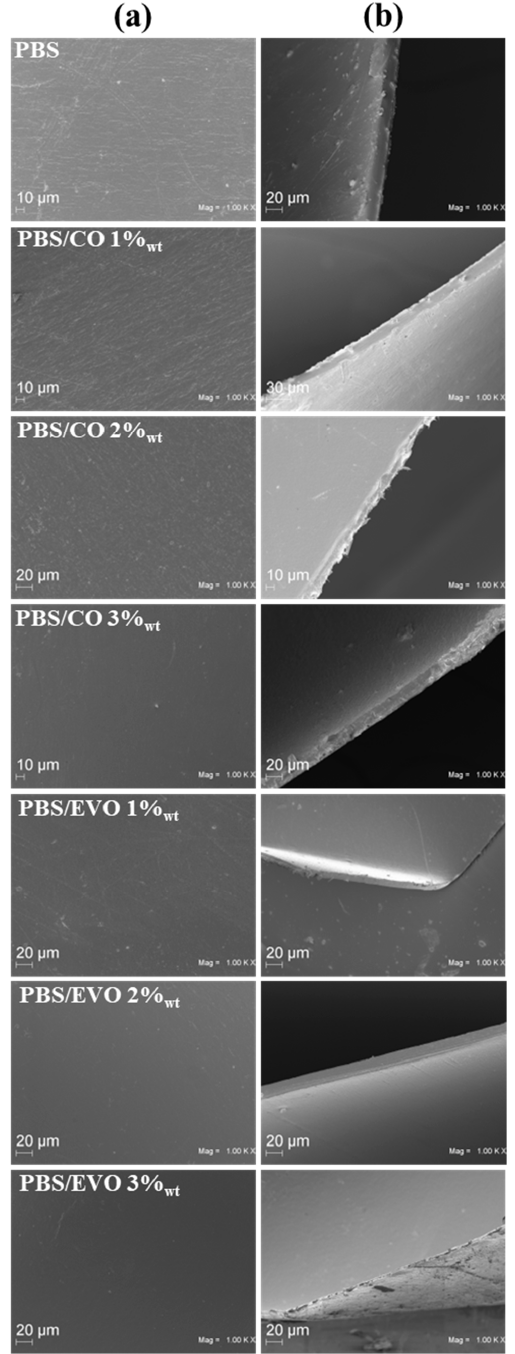
Figure 5. The SEM micrographs of the studied formulations: ( a ) film surfaces and ( b ) film thick- nesses.